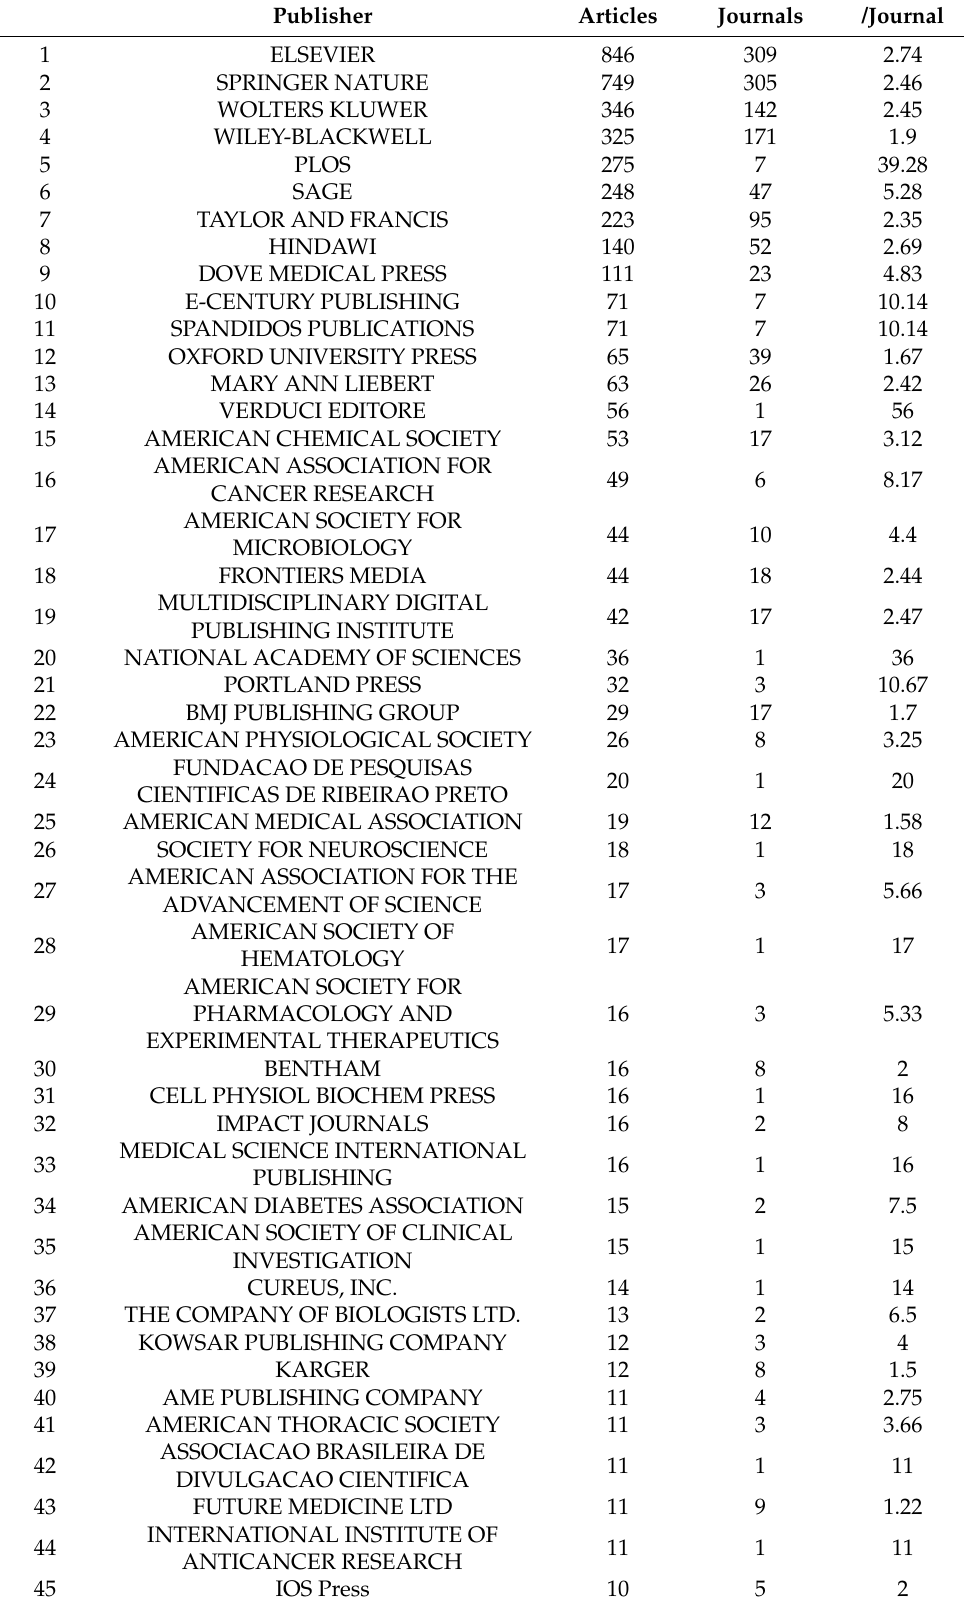
Table 2. Publishers with more than 10 retracted